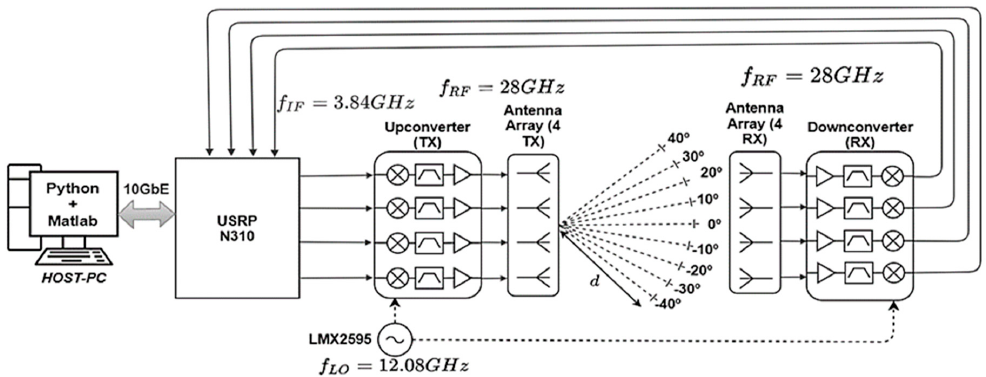
Figure 2. Block diagram of the proposed SDR beamforming system.